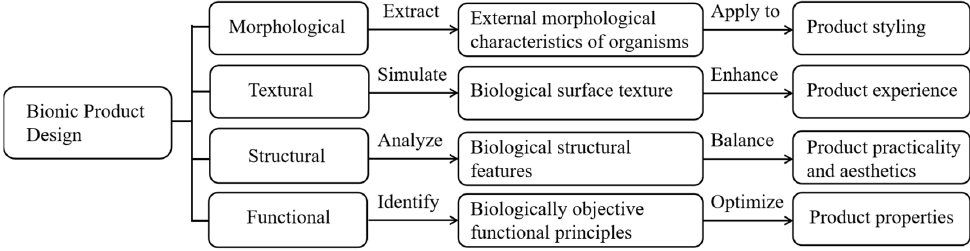
Figure 3. Summary and analysis of bionic design types and characteristics.